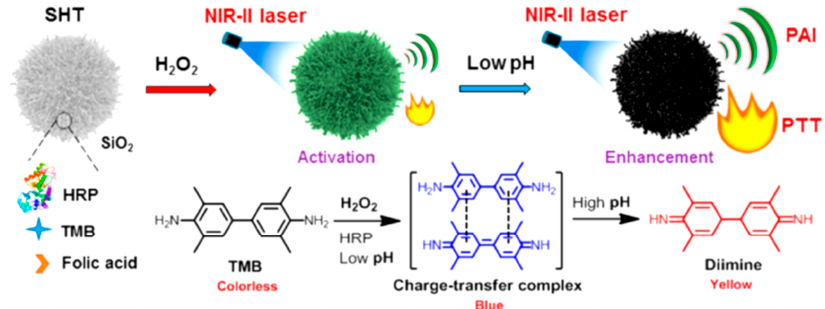
Figure 20. Description of formation of the tumor microenvironment-activated nanotheranostics (SHT), the activation in response to hydrogen peroxide, and acid enhancement for tumor-specific NIR-II photonanotheranostics. Reprinted with permission from [102]. Copyright, American Chemical Society (2019).